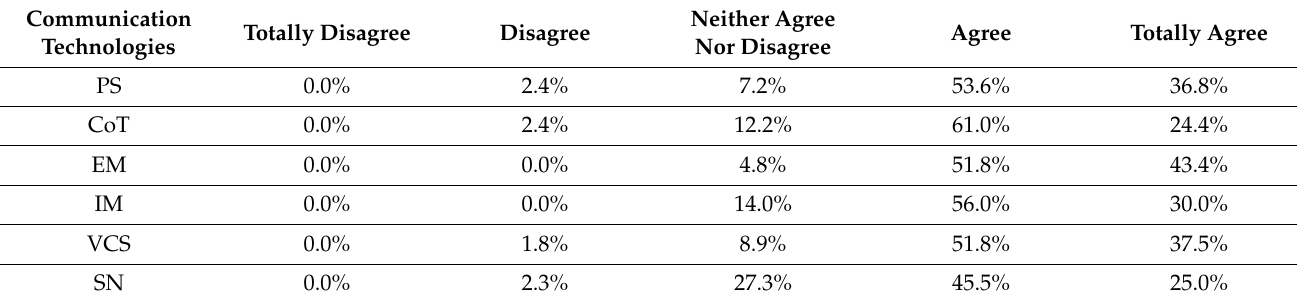
Table 23. Confirmation of expectations on the use of communication technologies by teachers. Communication